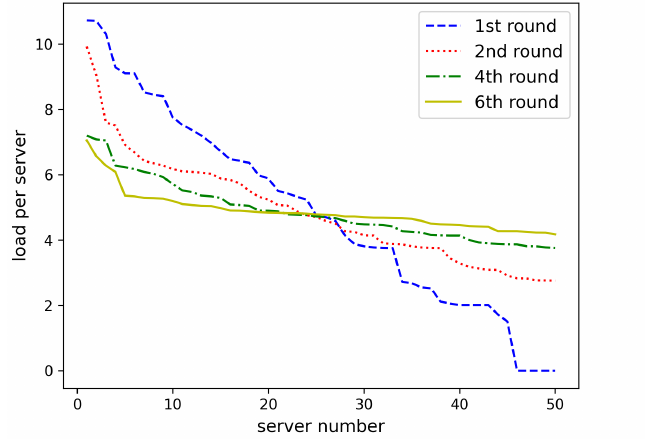
Figure 6. Rate of tasks completed within the delay constraints versus the task offload rate.